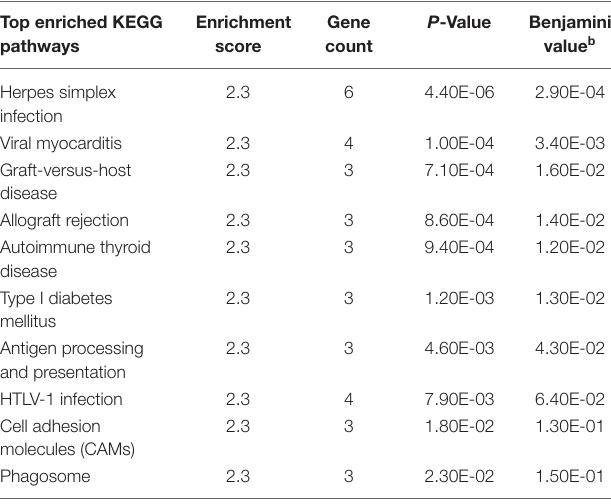
TABLE 8 | Pathway analysis of down-regulated genes due to HF diet in the hippocampus of 2 week-old piglets a . Top enriched KEGG pathways